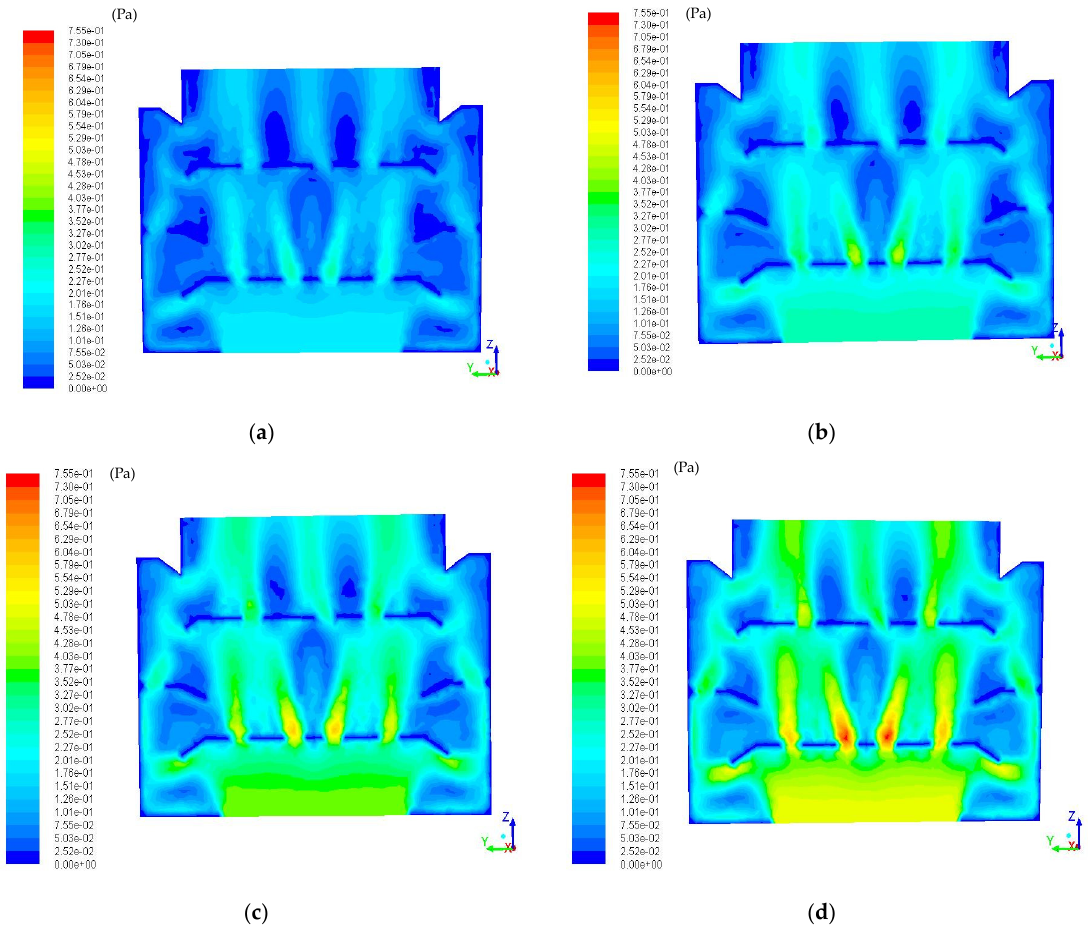
Figure 4. Computational fluid dynamics (CFD)-simulated velocity distribution changes in non-powered hydraulic mixing with the different inlet velocities. ( a ) Inlet velocity: 0.2 m/s; ( b ) inlet velocity: 0.3 m/s; ( c ) inlet velocity: 0.4 m/s; ( d ) inlet velocity: 0.5 m/s.